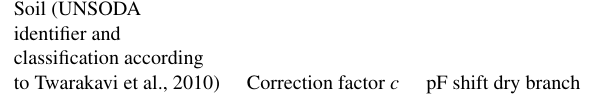
Table 2. The continuity correction factor c (Eq. 11) and the corre- sponding shift on the pF scale of the dry-branch correction for 21